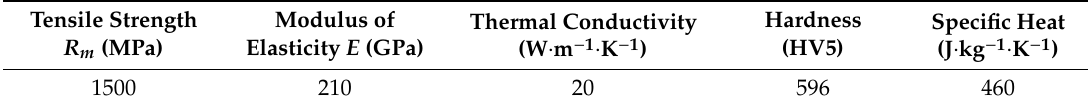
Table 2. Basic properties of the AISI 4340 steel.